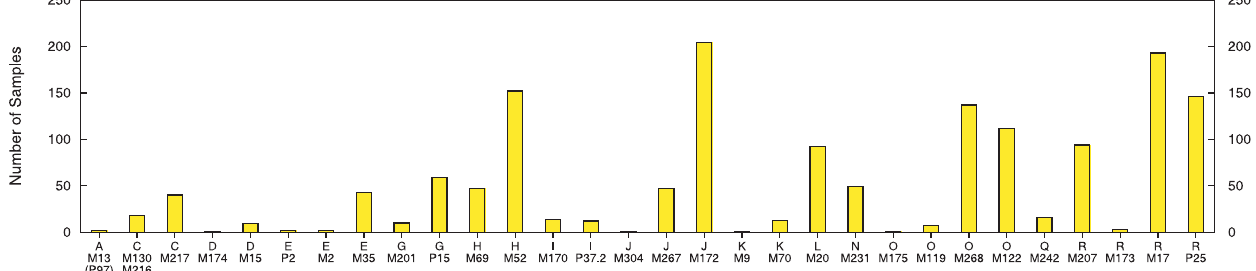
Figure 4. Frequency of 30 Y chromosome haplogroups inferred from a previously published sample of 1,527 Asian Y chromosomes. The samples were typed with 9 Y-STRs and a battery of Y-linked SNPs. Haplogroup frequencies are statistically significantly different from those in our ground-truth training set (Figure 1). Haplogroups are named according to the mutation-based nomenclature [12], which retains the major haplogroup information (i.e., 18 capital letters) followed by the name of the terminal mutation that the sample is positive for (see Figure S1).